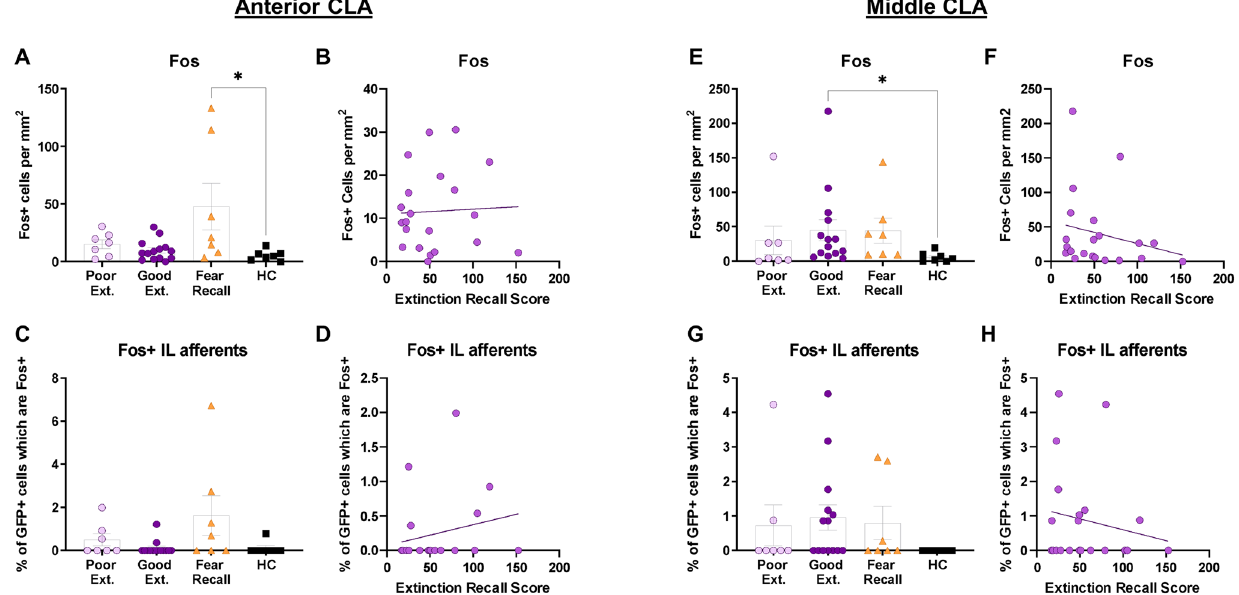
Figure 5. Fos activity is elevated in the middle claustrum among rats displaying good extinction recall. ( A ) Fear recall group, but not other group, shows elevated Fos activity relative to the home cage group in the aCLA. ( B ) No significant correlation between Fos expression in the aCLA and extinction recall. ( C ) No significant difference among groups in Fos expression within the IL-afferents of the aCLA. ( D ) No significant correlation between Fos expression within the IL-afferents and extinction recall in the aCLA. ( E ) Good extinction group, but not other group, shows elevated Fos activity relative to the home cage group in the mCLA. ( F ) No significant correlation between Fos expression and extinction recall in the mCLA. ( G ) No significant differences among groups in Fos expression within the IL-afferents of the mCLA. ( H ) No significant correlation between Fos expression within the IL-afferents and extinction recall in the mCLA. Error bars represent standard error of the mean. * p <